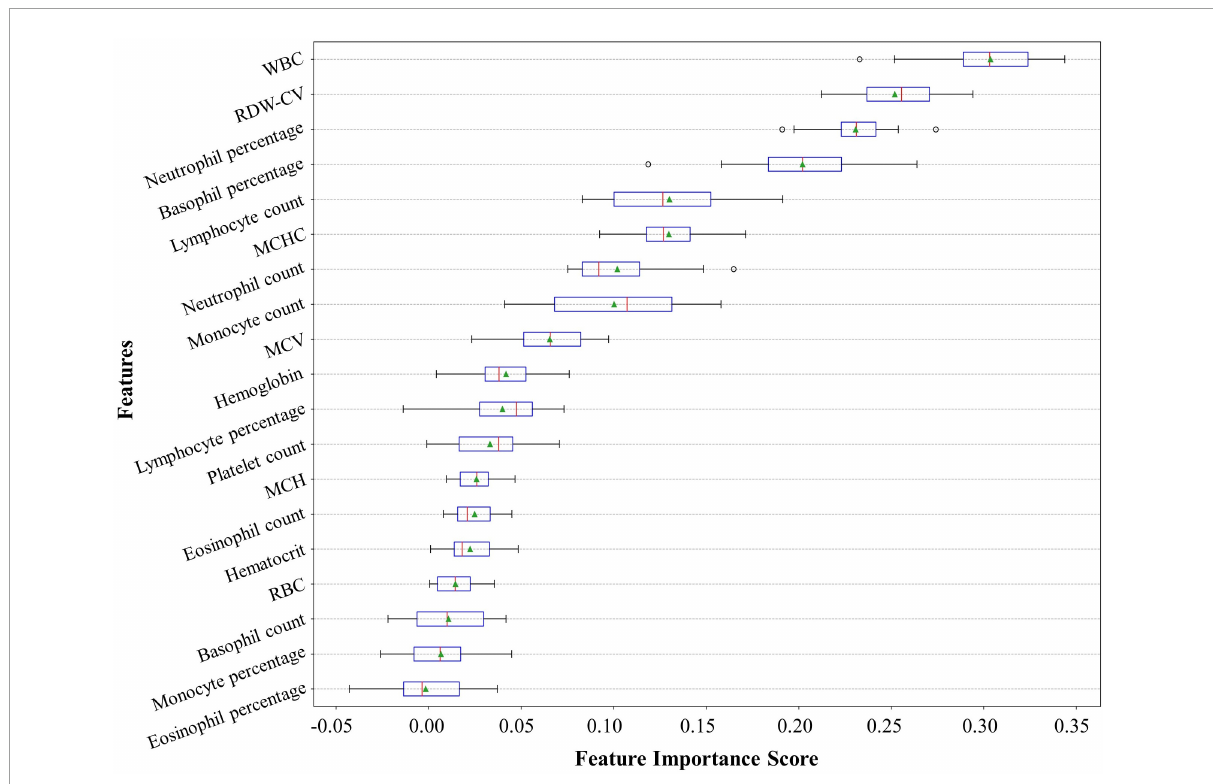
FIGURE5 Feature importance ranking of our neural network model. The feature importance rank denotes how heavily our model relies on a predictor variable. The relative importance rank of the 19 predictor variables from the complete blood count with differential (CBC w/diff) test in our model is shown. CBC w/diff, complete blood count with differential; WBC, white blood cell; RDW-CV, red cell distribution width-coefficient of variation; MCHC, mean corpuscular hemoglobin concentration; MCV, mean corpuscular volume; MCH, mean corpuscular hemoglobin; RBC, red blood